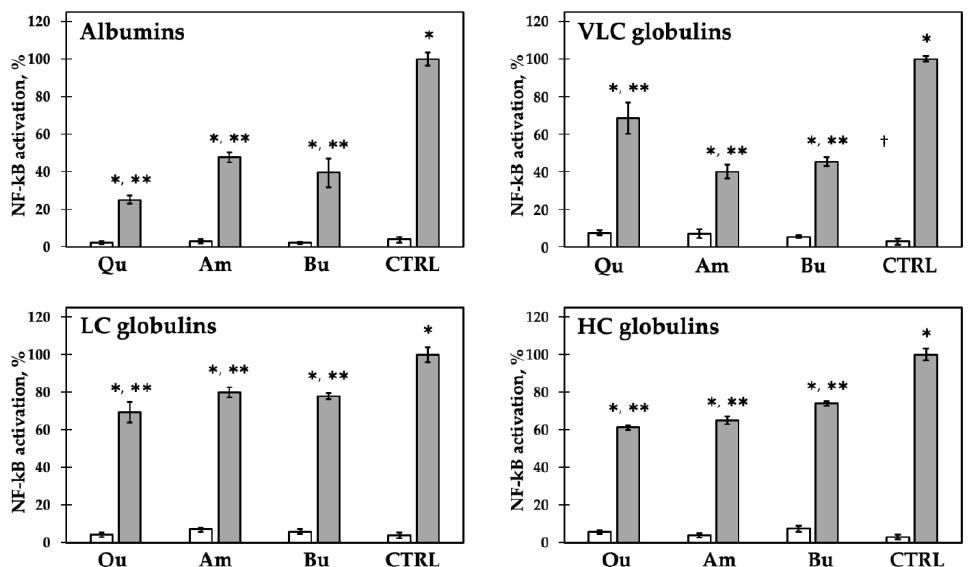
Figure 3. Inflammatory response of Caco-2 cells incubated with 1.0 mg/mL of each protein class without (white bars) or with (gray bars) IL-1 β . Response to IL-1 β alone was set as 100% (CTRL). Qu: quinoa; Am: amaranth; Bu: buckwheat. * p < 0.05 vs. CTRL without IL-1 β ; ** p < 0.05 vs. CTRL with IL-1 β . Each experiment was performed in triplicate.